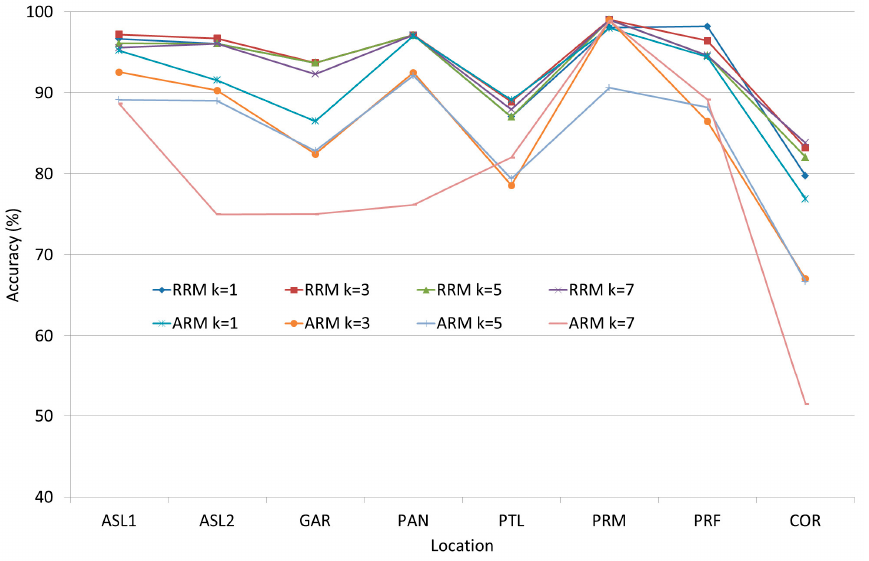
Figure 6. The accuracy of IPS when using KNN in each room.